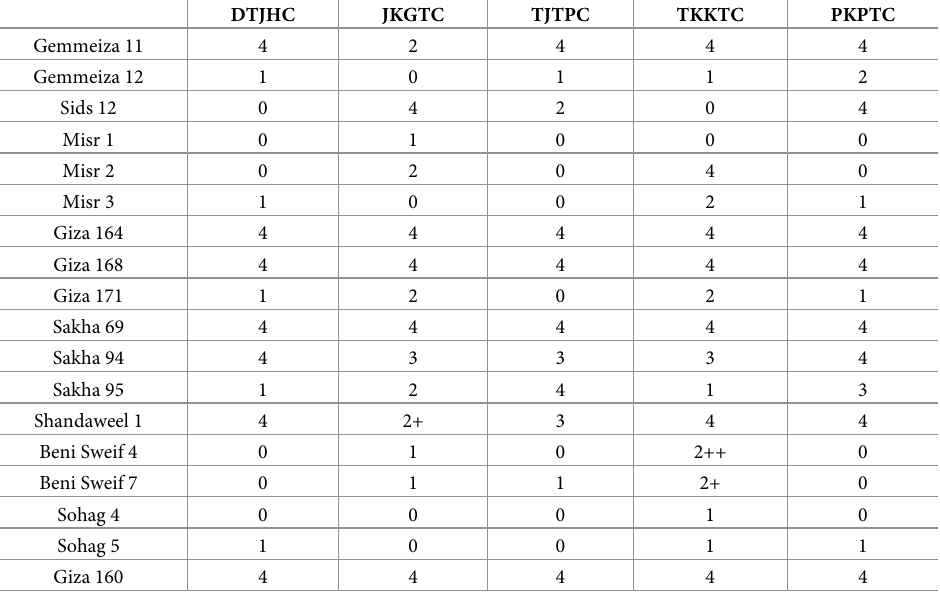
Table 3. Response of 18 wheat varieties against five leaf rust races at the seedling stage under greenhouse